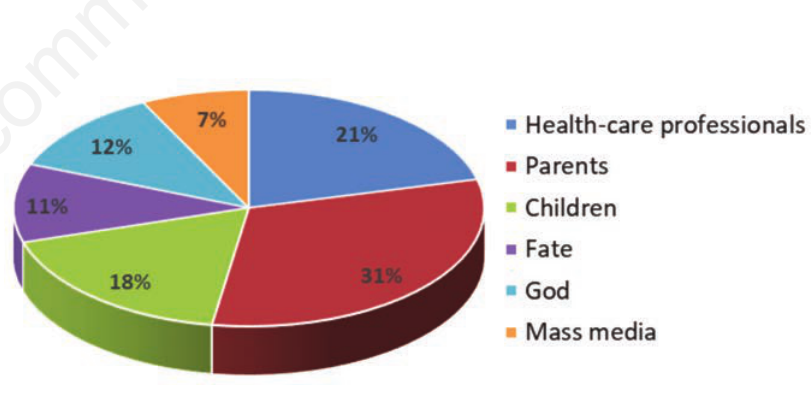
Figure 1. Descriptive statistics: mothers locus of control scales.